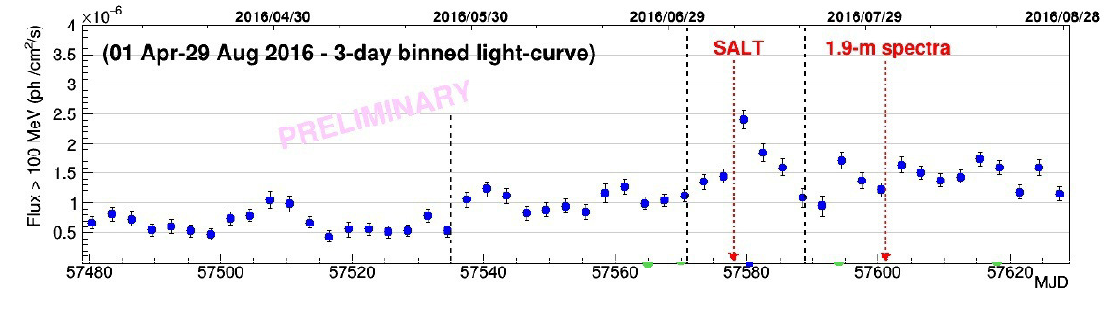
Figure 1. Three-day binned Fermi -Large Area Telescope (LAT) light curve at E > 100 MeV of 4C+01.02 for the period April–June